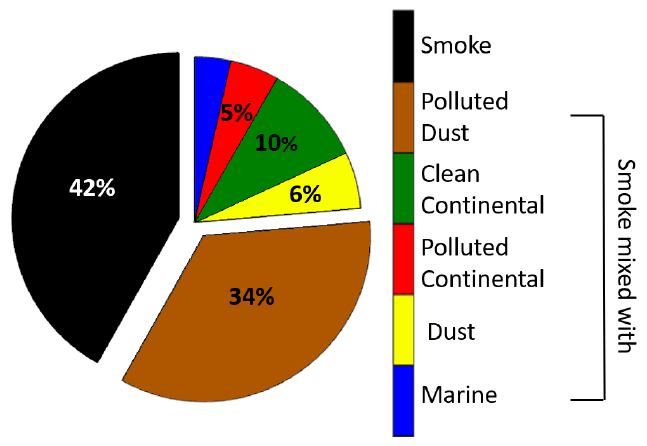
Figure 5. Percentages of aerosol layers mixing types for the total event, types found in percentages less than 3%, are not presented with numbers in the figure.